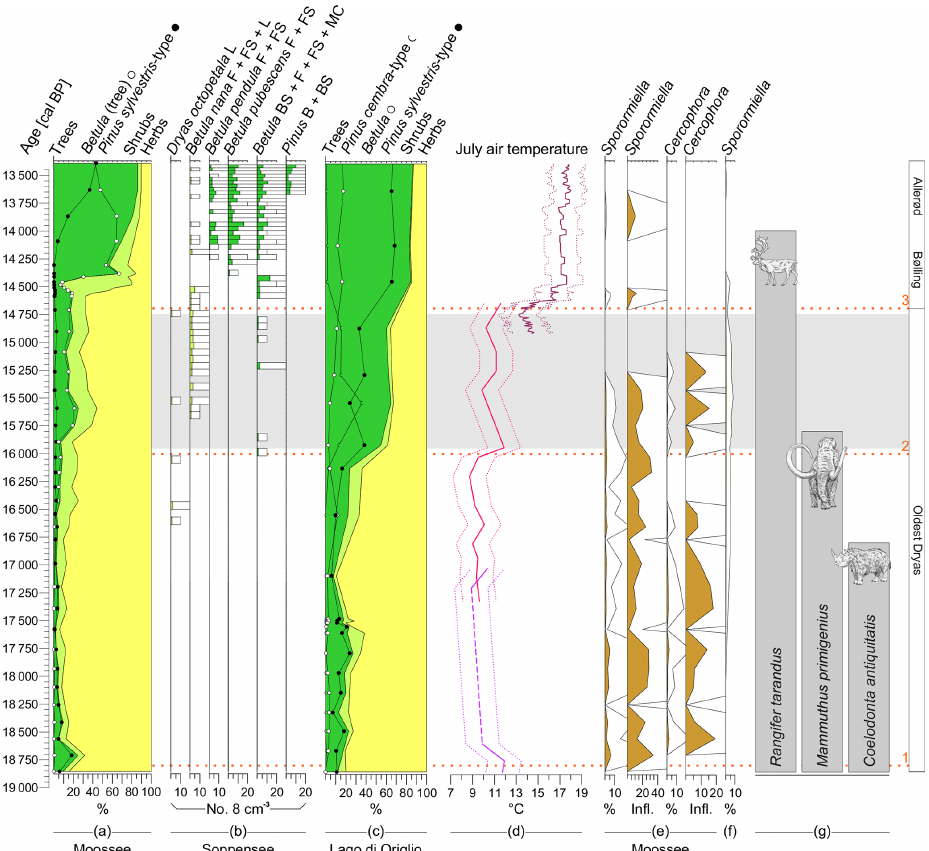
Figure 4. Composite graph. (a) Main pollen percentages of Moossee including pollen percentages of Betula (tree) and Pinus sylvestris - type. (b) Concentrations of selected plant macrofossils at Soppensee (Lotter, 1999). B: bud; BS: bud scale; F: fruit; FS: fruit scale; L: leaf; MC: male catkin. (c) Main pollen percentages of Lago di Origlio including pollen percentages of Betula , Pinus sylvestris -type and Pinus cembra -type (Tinner et al., 1999). (d) Mean July air temperature estimates for the altitude of Moossee (521ma.s.l.) using chironomid-based temperature reconstructions from Lago della Costa (light purple lines; Samartin et al., 2016), Lago di Origlio (pink lines; Samartin et al., 2012) and a chironomid-inferred stacked temperature record representing mean July air temperature estimates in the northern and central Swiss Alps (dark red lines; Heiri et al., 2015). Temperatures were corrected under the assumption of a constant modern temperature rate of 6 ◦ Ckm − 1 (Livingstone and Lotter, 1998) and plotted according to Finsinger et al. (2019). The Origlio record is only shown for the oldest part (older than 14600calBP). Dotted lines reflect standard error estimates. (e) Sporormiella and Cercophora percentages and influx values (spores per square centimeter per year) of Moossee. (f) Sporormiella percentages of Burgäschisee (Rey et al., 2017). (g) Presence and extinction of important Pleistocene megafauna (Nielsen, 2013; Cupillard et al., 2015). The horizontal light grey bar indicates the time window of local archeological findings (reindeer hunter camps; Bullinger et al., 1997; Harb, 2017; Nielsen, 2018). Empty curves show 10x exaggerations (b, e, f) . The orange horizontal dotted lines (1–3) mark important climatic breaks on the basis of temperature changes (Finsinger et al., 2019). 1: onset of the Oldest Dryas (19000calBP; Wirsig et al., 2016); 2: post-HE-1 warming (16000calBP; Samartin et al., 2012); 3: onset of the Bølling (14700calBP; van Raden et al.,